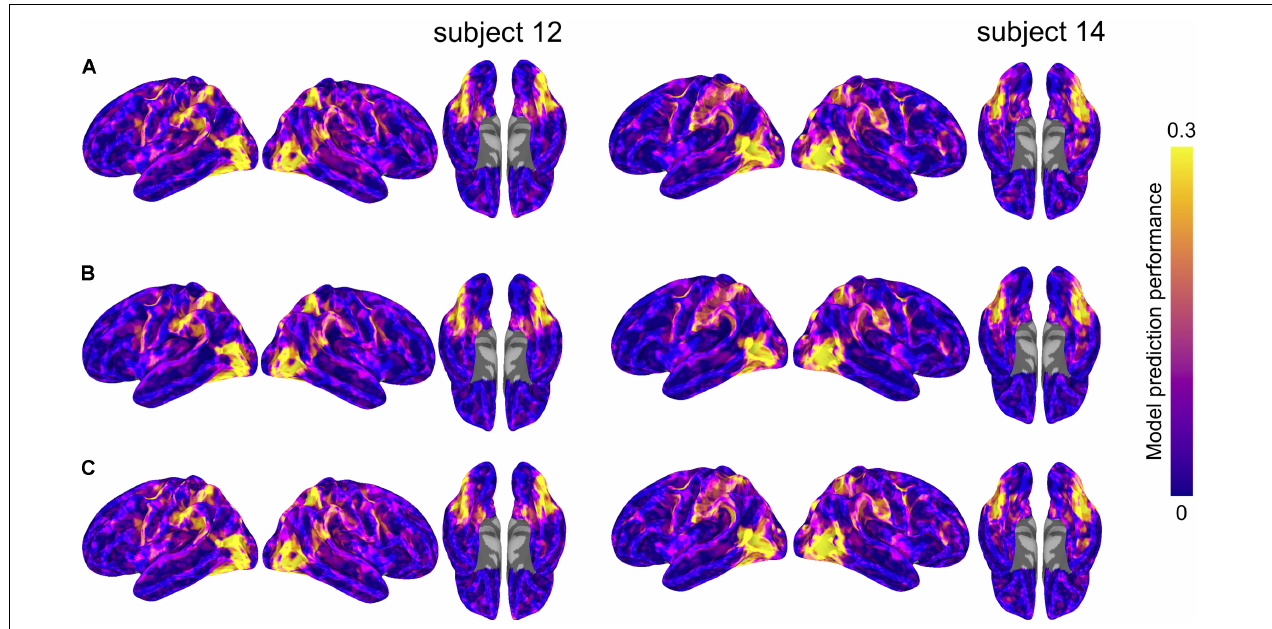
FIGURE 3 | Model prediction performance maps for two example subjects (left and right). Colored vertices reflect the Pearson correlation between the predicted and actual time series averaged across the four test runs. Three types of models are presented: (A) within-subject model performance maps; (B) between-subject anatomically aligned model performance maps; and (C) between-subject hyperaligned model performance maps. Maximum correlations are 0.37 (both subjects 12 and 14, area LO, all three maps) and correlations at the 95% level for vertices within the mask ranged from 0.29 to 0.31. All maps are unthresholded and uncorrected for multiple tests.